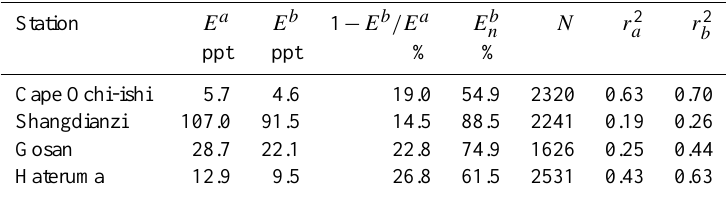
Table 3. Error characteristics for HCFC-22 by station. E a and E b denote the a priori and, respectively, a posteriori RMS errors for the full data set, including outliers, 1 − E b /E a is the relative error reduction. E b n is the a posteriori error normalized with the standard deviation of the observed mixing ratios. N denotes the number of observations. r 2 a and r 2 are the squared Pearson correlation coefficients between the b observations and the a priori and, respectively, a posteriori model